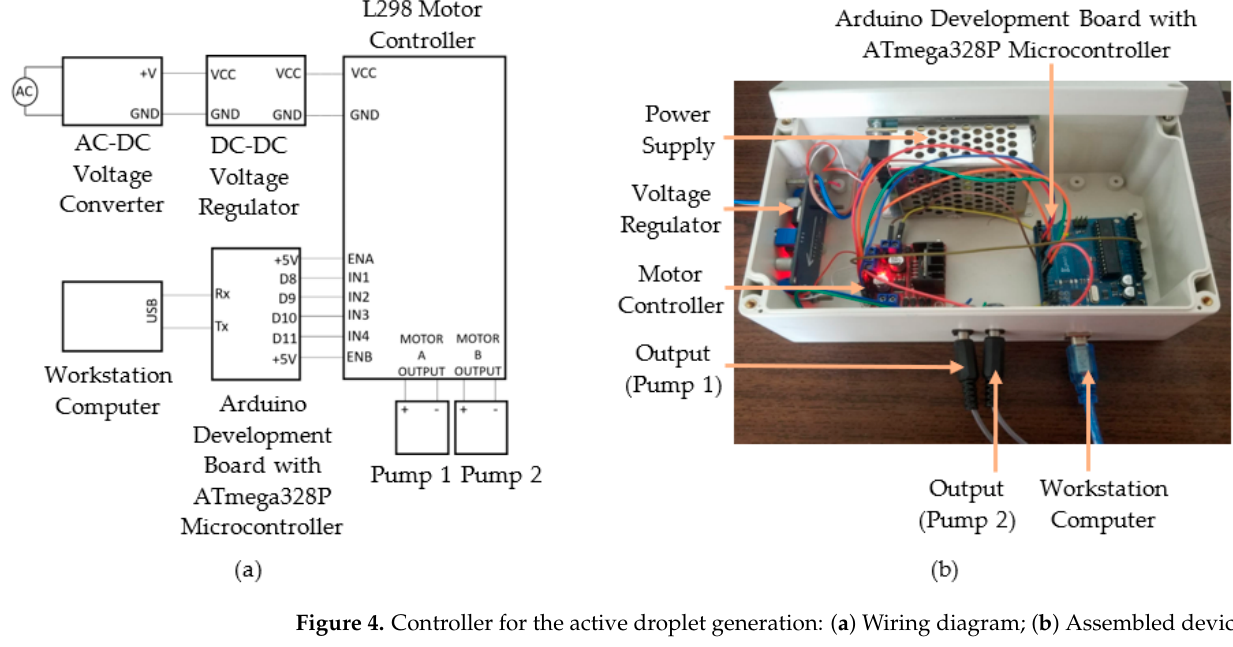
Figure 4. Controller for the active droplet generation: ( a ) Wiring diagram; ( b ) Assembled device.